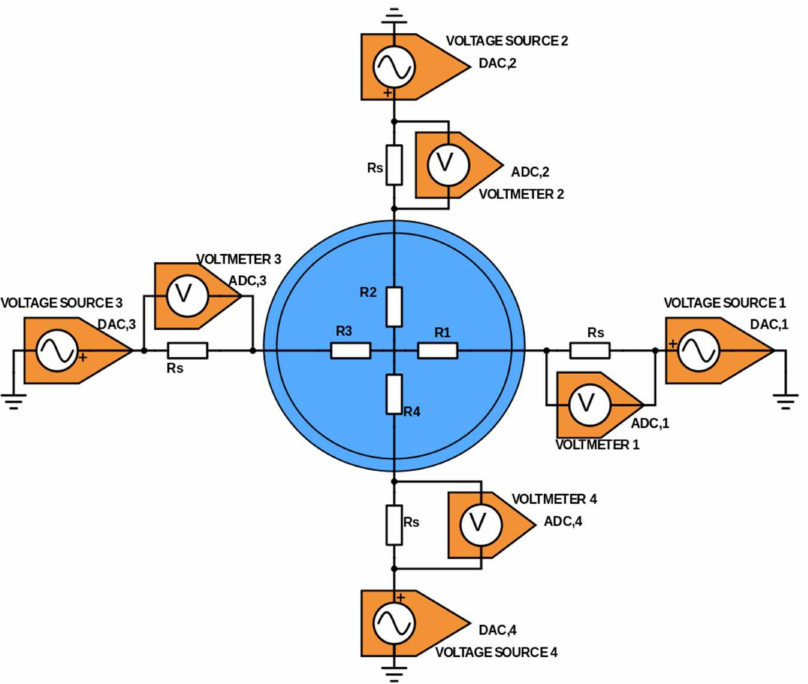
Figure 3. Sketch of the setup for the proof-of-concept experiment. In the blue disk, is the mock-up of a test section. Voltage sources generate the excitation signals, and voltmeters measure the system response (currents) across sense